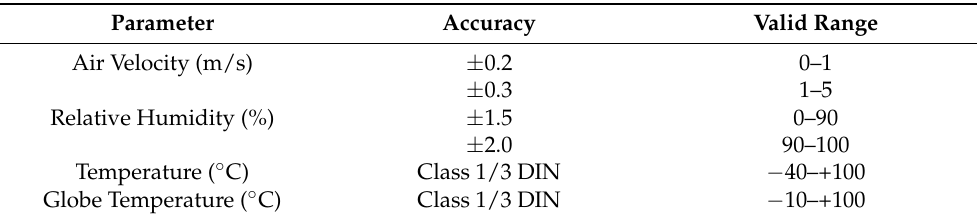
Table 4. Physical measurements and accuracy of the thermal microclimate station.